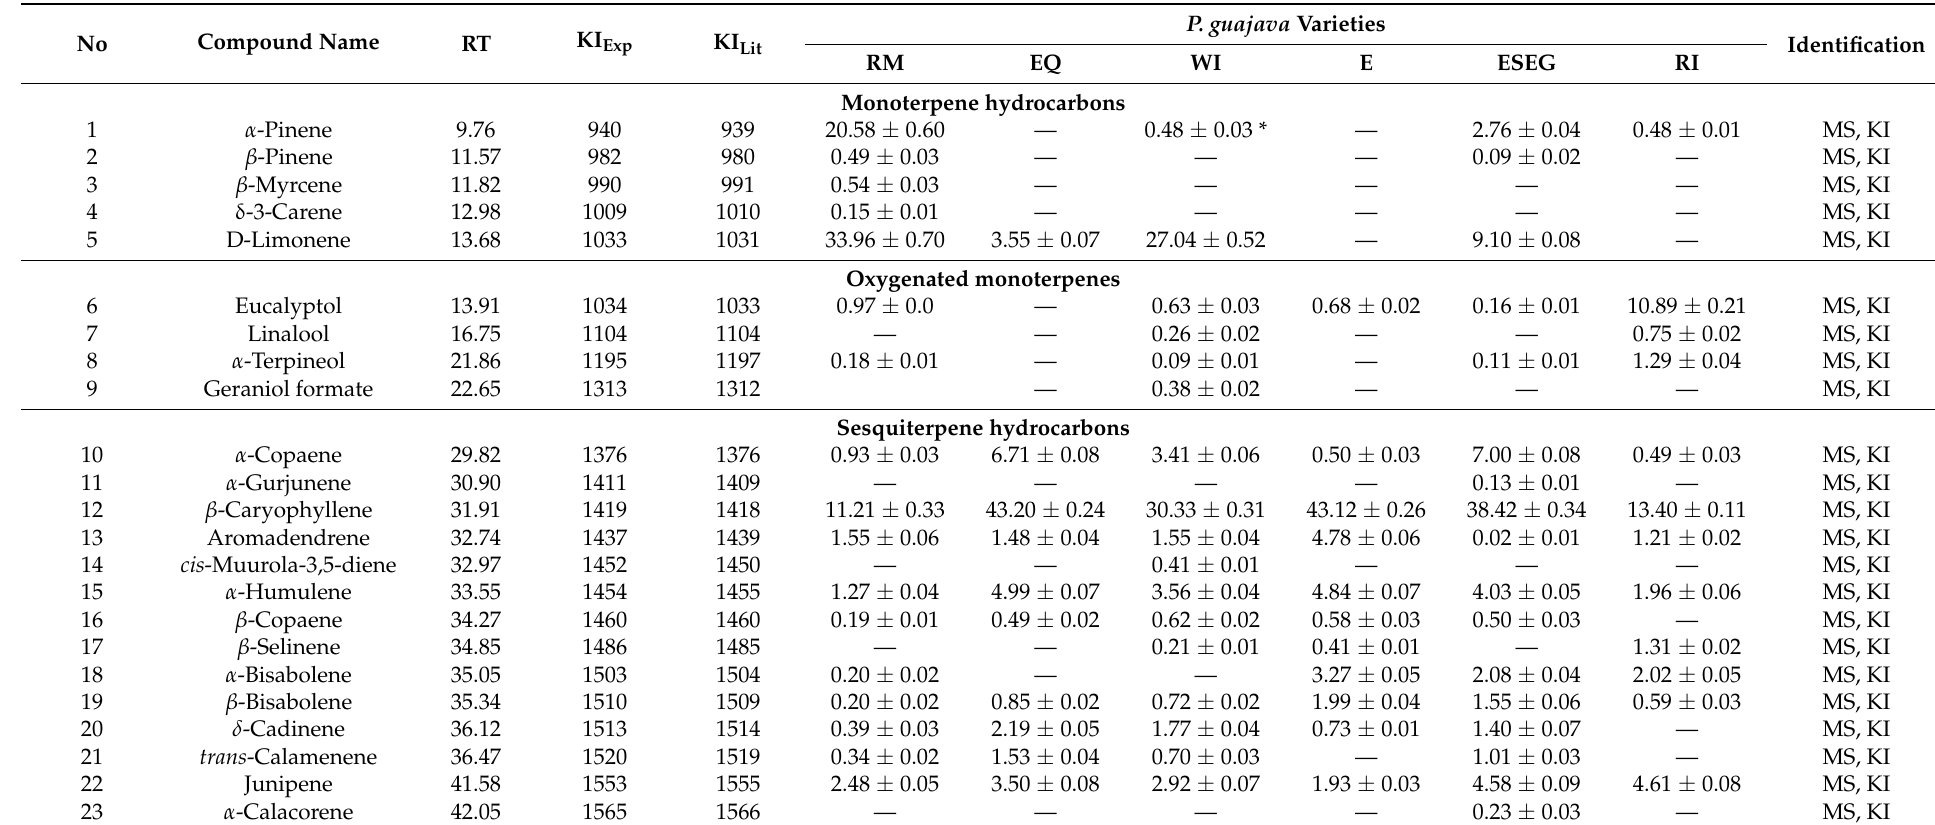
Table 1. Chemical compositions of the essential oils (EOs) extracted from the leaves of six varieties of P. guajava